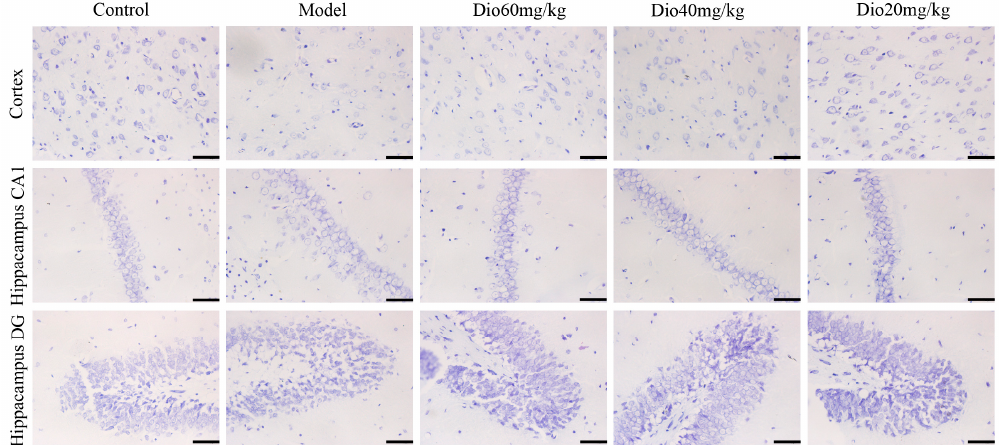
Figure 3. Effects of dioscin on Nissl staining of cortex and hippocampus in aging rat brains (400× magnification). Scale bar = 50 μ m.